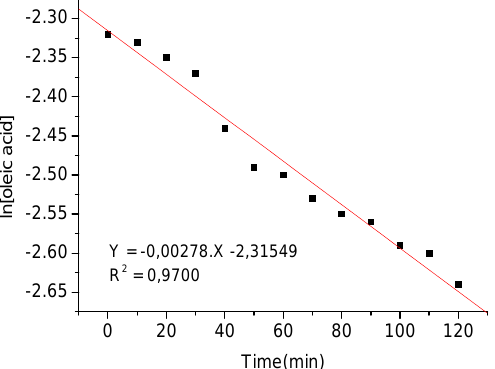
Figure 3 . Arrenhius plot of oleic acid concentration as function of time for ethanolysis catalyzed by SnCl 2